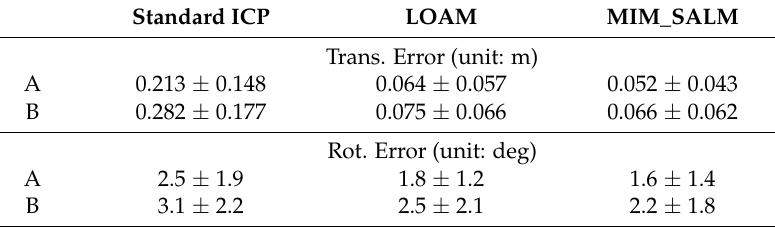
Table 1. The localization error results of different